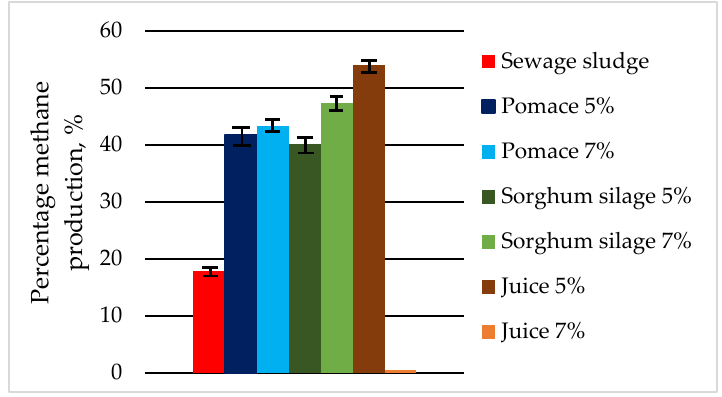
Figure 3. Average percentage methane production from sewage sludge and substrates from sorghum.